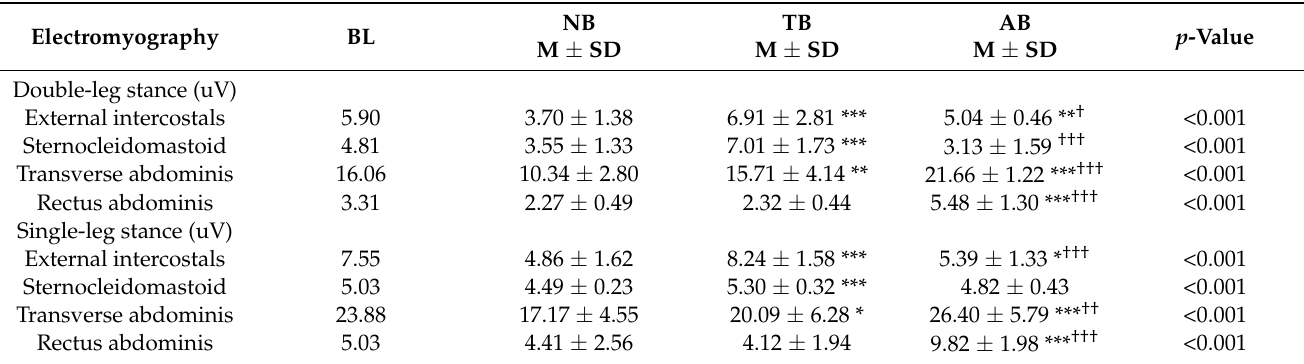
Table 3. Muscle activity according to the type of